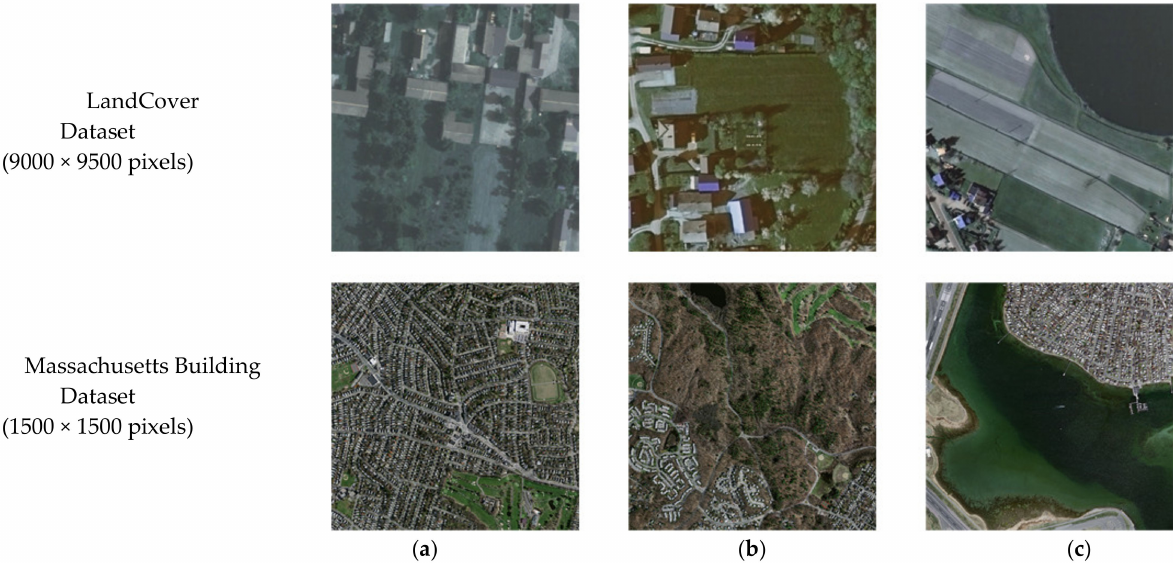
Figure 7. Comparison of two kinds of datasets. ( a ) residential area; ( b ) rural area; ( c ) seaside